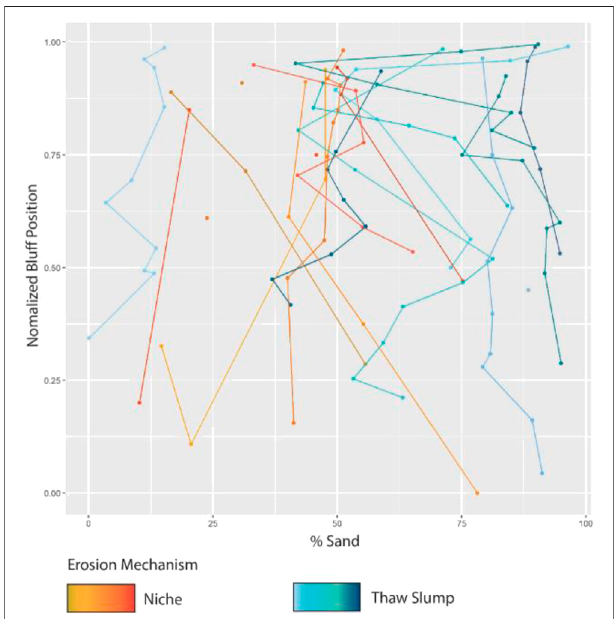
FIGURE 7 | Plot showing sand content (%) as a function of normalized bluff position (depth/bluff. height) at the various sites for which sediment data was available. The plot also identi fi es the erosion mechanism inferred based on aerial photo analysis. Note, in some instances, only a single bluff sample was analyzed and these data are plotted as dots. Note, the low sand contentofonecore(BSC41bin Table1 ),identi fi edasasiteofblufffacethaw/ slump erosion, appears to be an outlier. However, the coarse sediment areal density of this site (82.7 g/cm 2 , Table 1 ) is similar to that calculated for other bluff face thaw/slump sites.